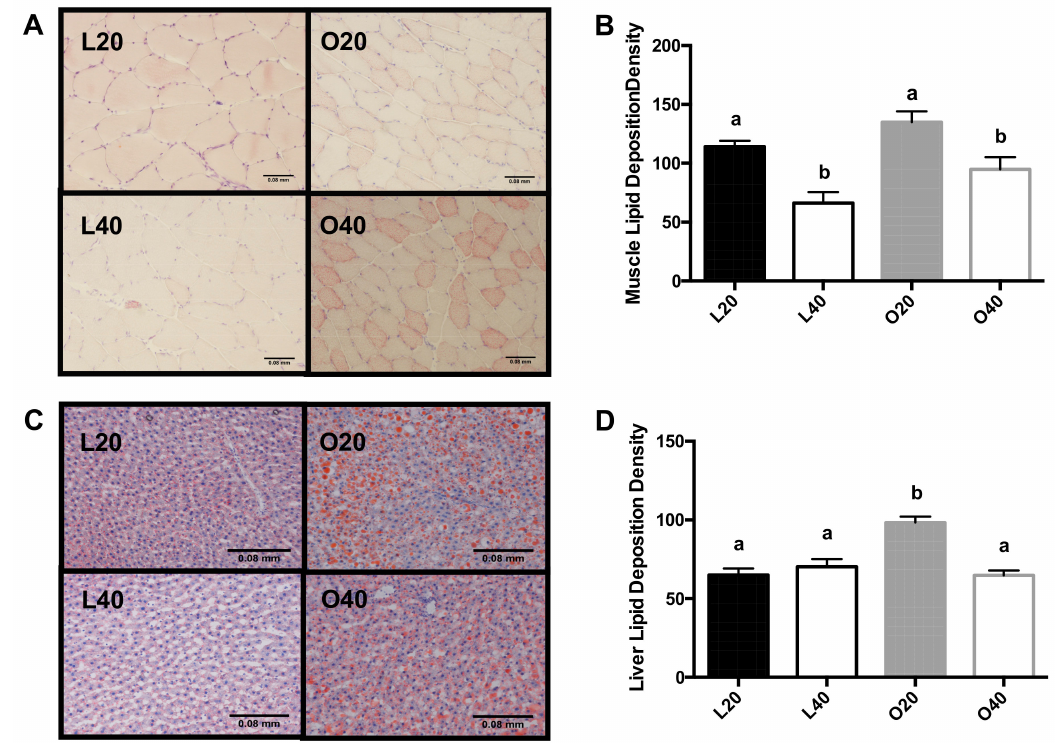
Figure 4. Representative skeletal muscle (gastrocnemius; 8 µ m thickness and 200 × magnification; 4.17 pixels/um) and liver sections (12 µ m thickness and 200 × magnification; 4.17 pixels/um) were obtained from lean control (L) or obese Zucker (O) rats following 12 weeks of consuming either a 20% protein or 40% protein diet and stained for fat deposition using Oil Red O staining. ( A ) Skeletal muscle lipid deposition, scale indicates 0.08 mm; ( B ) Quantification of lipid deposition in skeletal muscle, scale indicates 0.08 mm; ( C ) Liver lipid deposition; ( D ) Quantification of lipid deposition in liver. Obese rats had higher fat deposition in muscle and liver compared to lean rats. Rats receiving the 40% protein diet tended to have less fat deposition than those fed the 20% protein diet. L20, lean 20% protein; L40, lean 40% protein; O20, obese 20% protein; O40, obese 40%